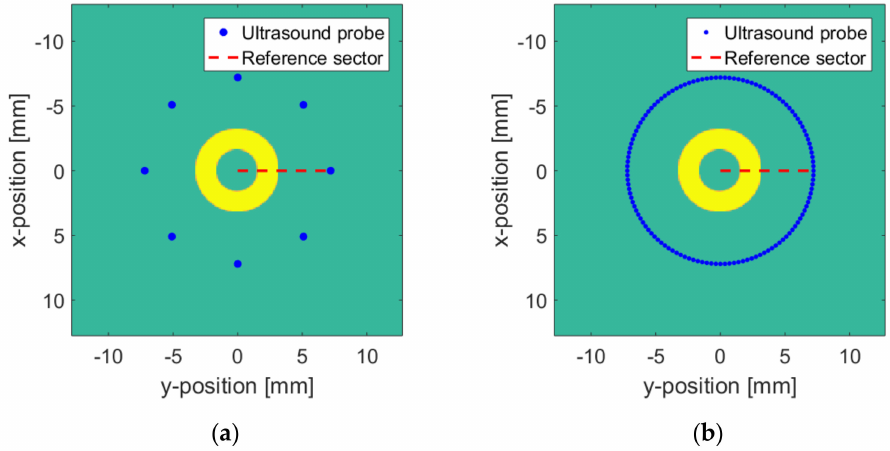
Figure 13. Numerical model: ( a ) ∆ v = 8; ( b ) ∆ v = 128.